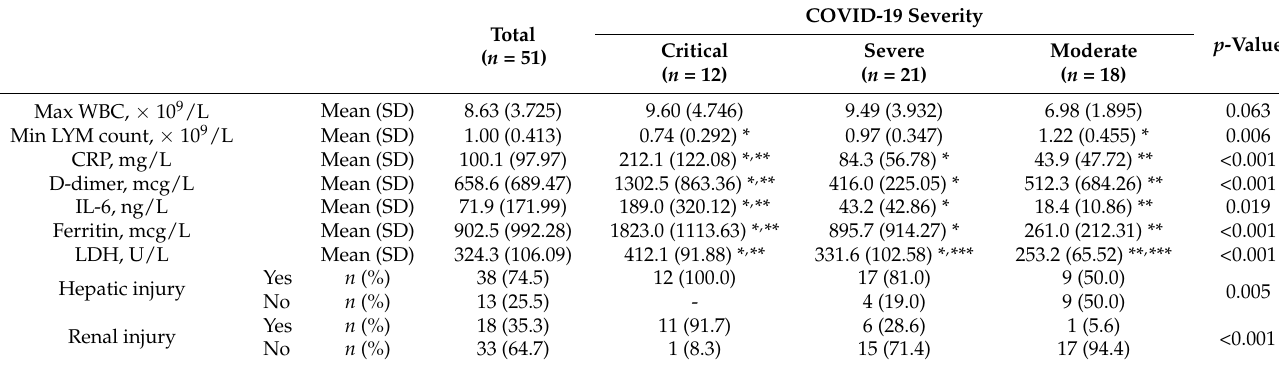
Table 3. Laboratorial data and COVID-19